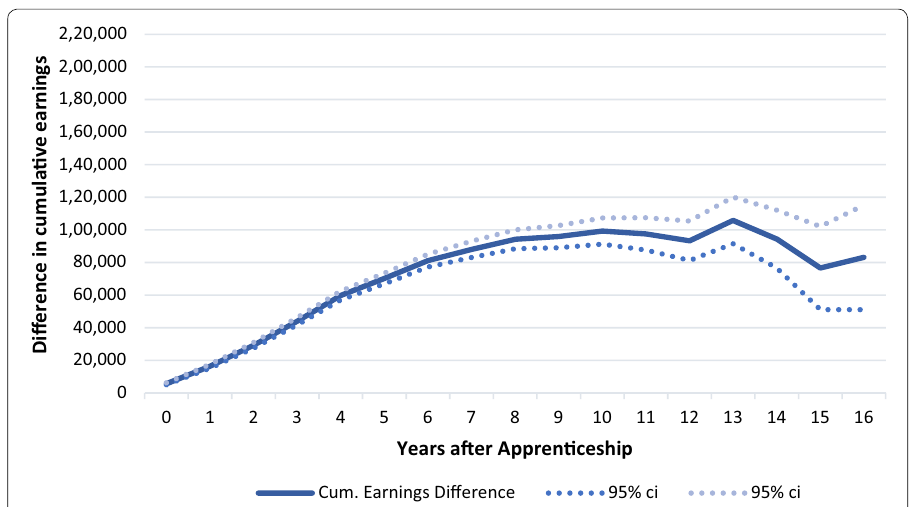
Fig. 8 Differences in cumulative earnings between matched foremen and polytechnic academics (N